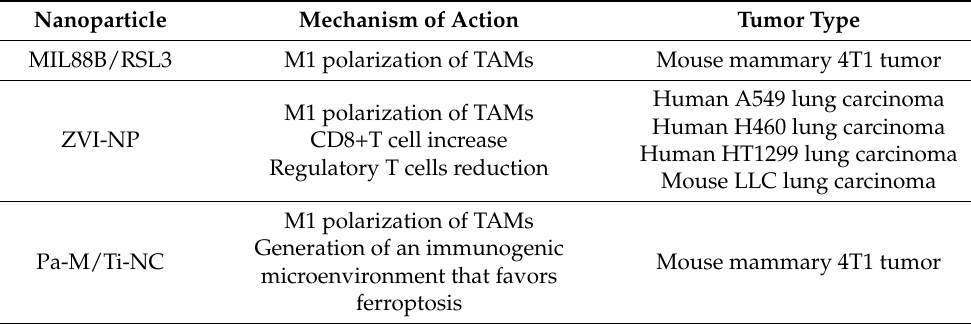
Table 3. Nanoparticles for